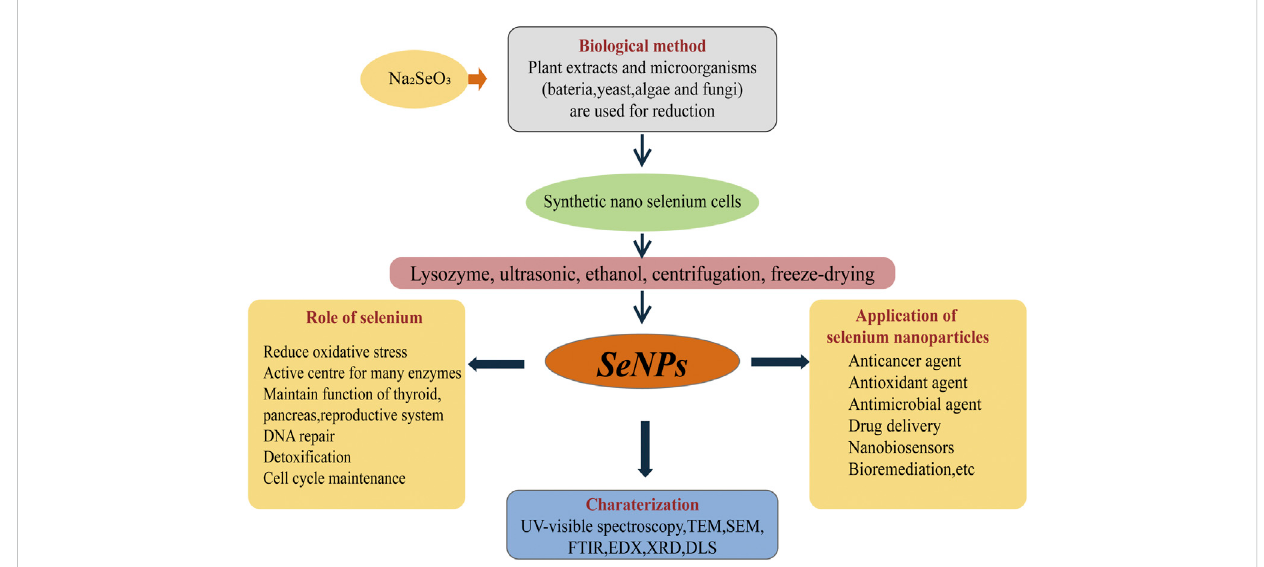
The “ green synthesis ” pathway of BioSeNPs and applications. Na 2 SeO 3 was added to the fermentation medium of microbes (bacteria, yeast and fungi) to produce nano-selenium cells. The nano-selenium particles were collected by centrifugation, wall breaking, extraction and freeze-drying. Through TEM, FTIR, EDX, XRD and UV-visible spectroscopy, the morphology and content of nano-selenium can be observed and characterized. The applications of nano-selenium are broad, mainly including anticancer agents, antimicrobial agents, bioremediation sensors and so on.